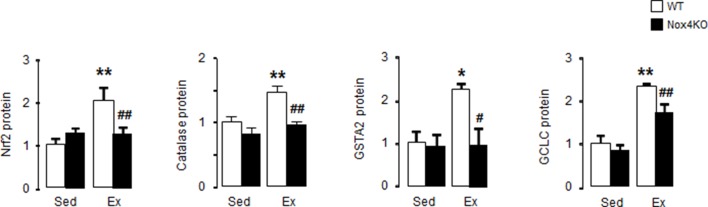
Quantification of Western blots in Figure 1E.Protein levels of Nrf2 and its main targets in the hearts of Nox4KO and WT mice before (Sed) and after exercise (Ex). *p<0.05, **p<0.01 vs respective sedentary control. #p<0.05, ##p<0.01 vs WT/Ex, 1-way ANOVA followed by Tukey post hoc analysis (n = 4–6/group). GSTA2: glutathione S-transferase A2, GCLC: glutamate cysteine ligase catalytic subunit.